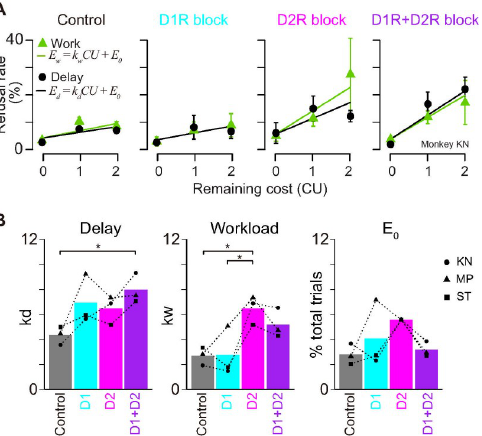
Fig 7. Effect of both D 1 R and D 2 R blockades on cost evaluation for motivation. (A) Representative relationship between refusal rates (in monkey KN; mean ± SEM) and remaining costs for workload (green) and delay trials (black). (B) Best-fit parameters, workload discounting ( k w ), delay discounting ( k d ), and intercept ( E 0 ) are plotted for each treatment condition. Bars and symbols indicate mean and individual data, respectively. D 1 R+D 2 R indicates the data obtained under both D 1 R and D 2 R blockades at MO, while D 1 R and D 2 R blockades at HO resulted in almost no correct performance (see text). All parameters are derived from the best fit of model #1 in S3 Table. Asterisks represent significant difference ( � p < 0.05, 1-way ANOVA with post hoc Tukey HSD test). The data underlying this figure can be found on the following public repository: https://github.com/minamimoto-lab/2021-Hori-DAR. D 1 R, D 1 -like receptor; D 2 R, D 2 -like receptor; HO, high occupancy; HSD, honestly significant difference; MO, moderate occupancy.